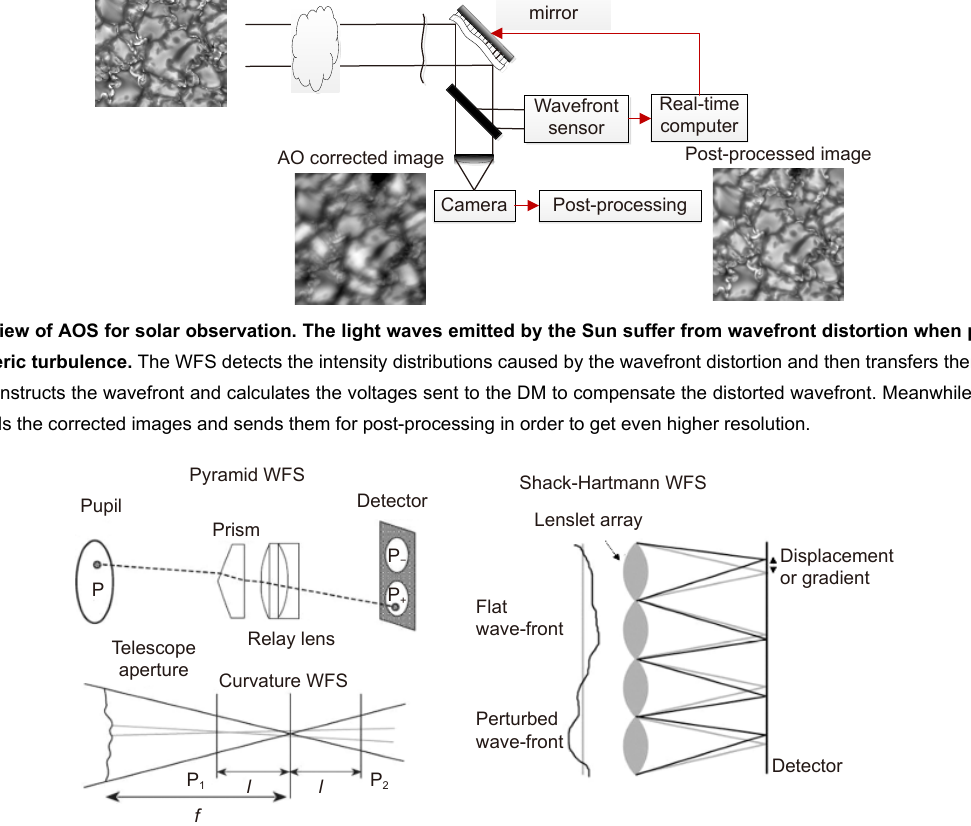
Fig. 2 | Principles of three kinds of WFS. Figure reproduced with permisson from ref. 32 , Annual Reviews